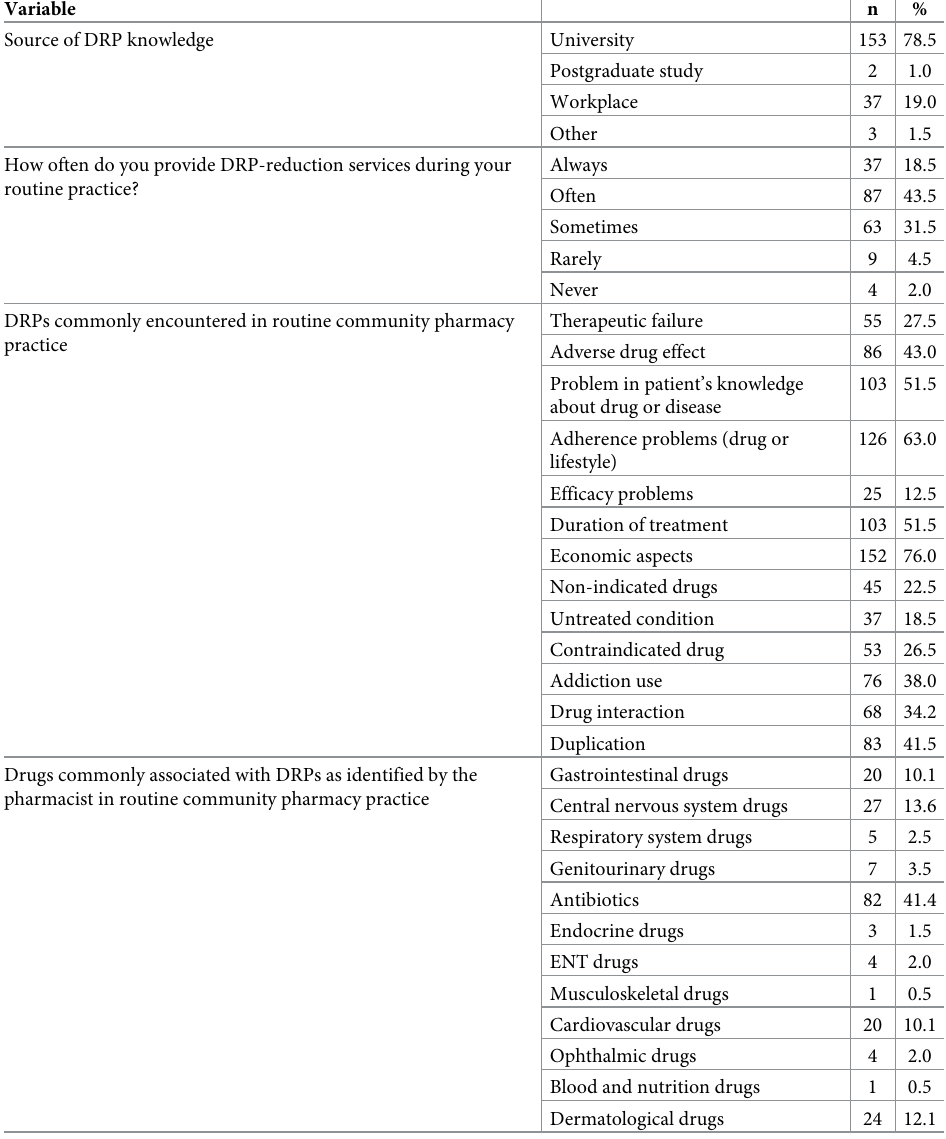
Table 2. Overall provision of DRP service, DRPs encountered, and drugs commonly associated with DRP services among community pharmacists (N =